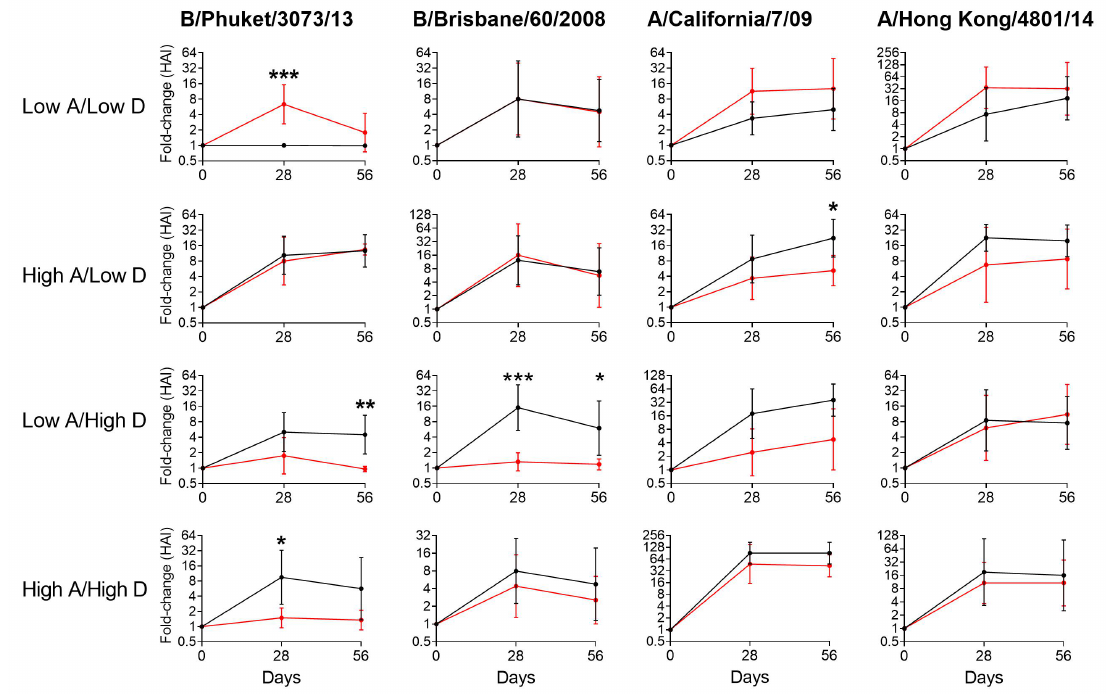
Figure 1. Estimated fold change in hemagglutination inhibition (HAI) responses compared between placebo (black) and vitamin A and D supplement (A&D, red) study groups at di ff erent time points of the study in season 2016–2017. Participants were placed into one of four groups based on vitamin levels. Cut-o ff s for su ffi ciency (termed “high”) were ≥ 22,000 ng / mL for retinol-binding protein (RBP) and ≥ 30 ng / mL for 25(OH)D. Groups were “Low A / Low D”, n = 10; “High A / Low D”, n = 12; “Low A / High D,” n = 11; “High A / High D,” n = 11 (see Table 2). For each of the four viruses, the GEE model was constructed with log2-transformed HAI titers as the response, age, race, and a three-way interaction among time, incoming vitamin levels, and study groups as covariates, and the first order autoregressive (AR1) as the working correlation structure. Estimated mean fold changes are plotted with 90% confidence intervals. p -values were obtained from post hoc comparisons from GEE models (* p < 0.05, ** p < 0.01, *** p <